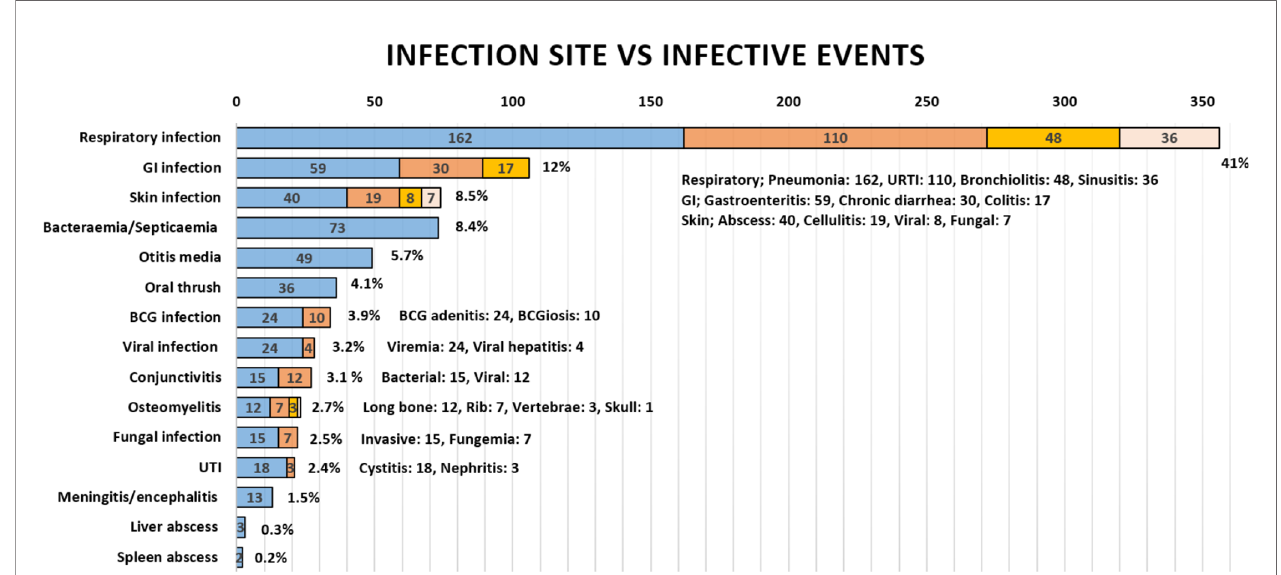
FIGURE 1 | The frequency of infections in Omani patients with IEI according to infection site. GI, gastrointestinal; BCG, Bacillus Calmette – Guerin; UTI, urinary tract infection; URTI, upper respiratory tract